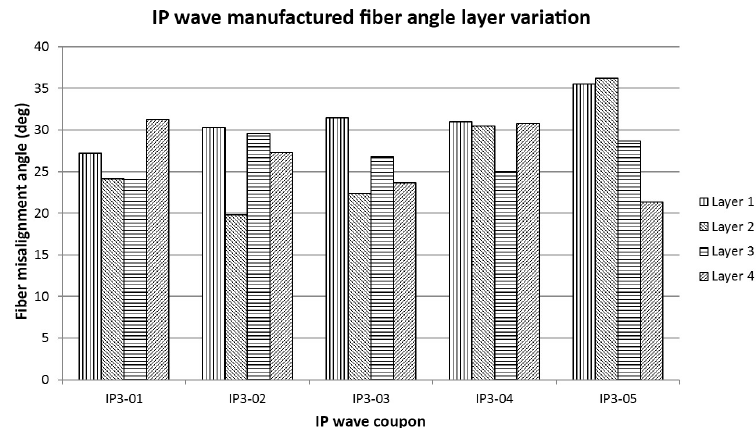
Figure 9. Examples of layer-by-layer fiber wave